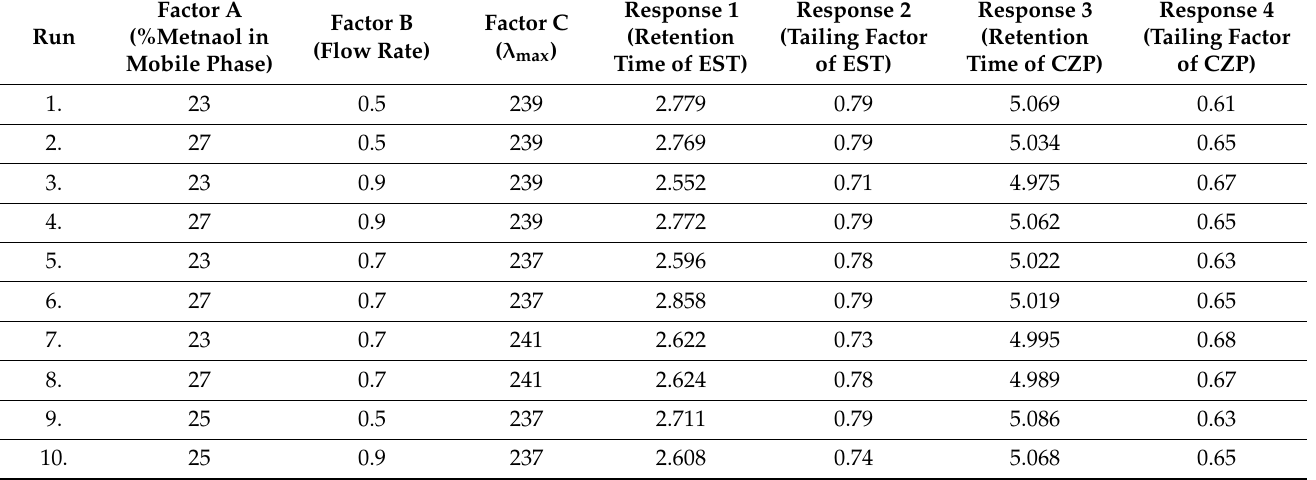
Table 1. Box-Behnken design (BBD)